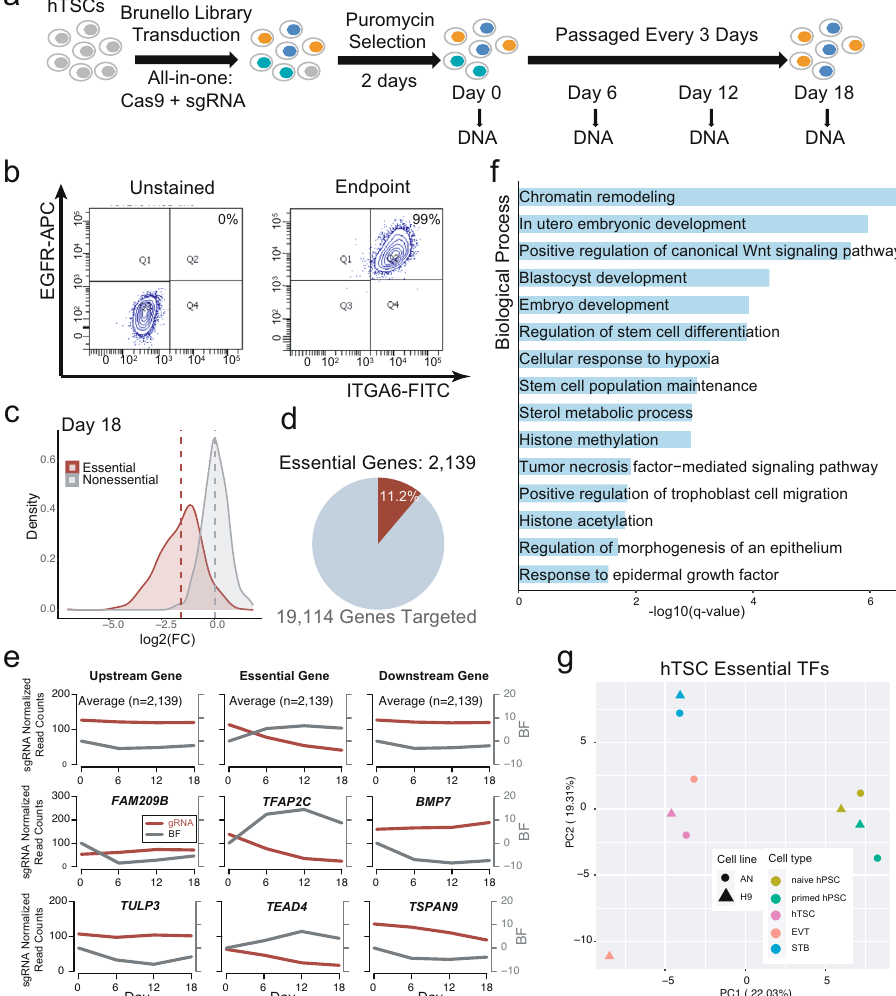
Fig. 1 A genome-wide CRISPR-Cas9 knockout screen identi fi es hTSC EGs. a The experimental scheme of the CRISPR screen. b Flow cytometry analysis for hTSC markers ITGA6 and EGFR in BT5 hTSCs following the CRISPR screen endpoint. c Fold change distribution of sgRNAs targeting core essential and nonessential genes 26 at day 18 of the screen. Note that the Log2 fold change (L2FC) of the core EGs gradually decreased relative to day 6 and day 12, while the L2FC of the nonessential genes largely remained unchanged across different timepoints. d Percentage of essential genes (EGs) identi fi ed among all targeted genes. e The mean of sgRNA normalized read counts and Bayes Factors (BFs) of all or selected hTSC EGs and their neighboring up- and downstream genes over time. The results are representative of two independently transduced screening experiments. f Selected GO Biological